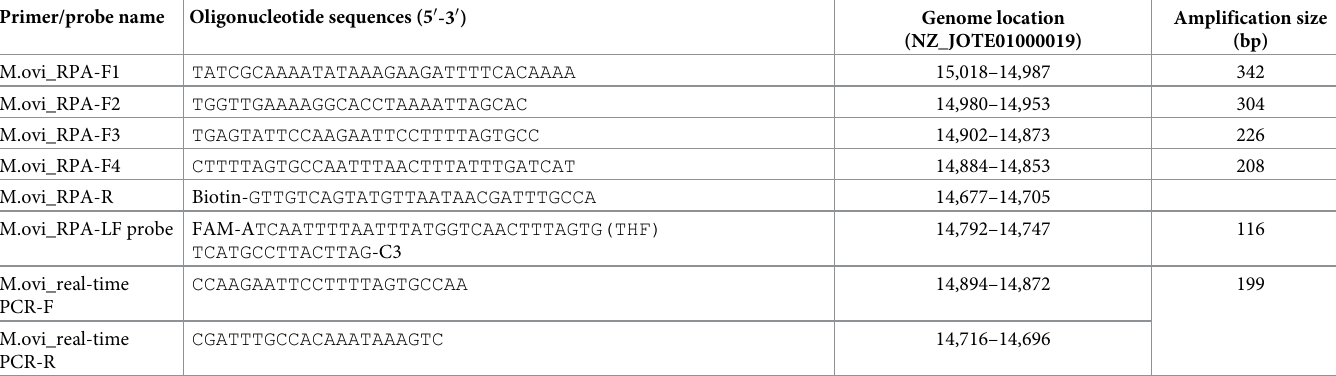
Table 1. Primers and probe used in RPA-LFD assay and real-time PCR development. Primer/probe name Oligonucleotide sequences (5 0 -3 0